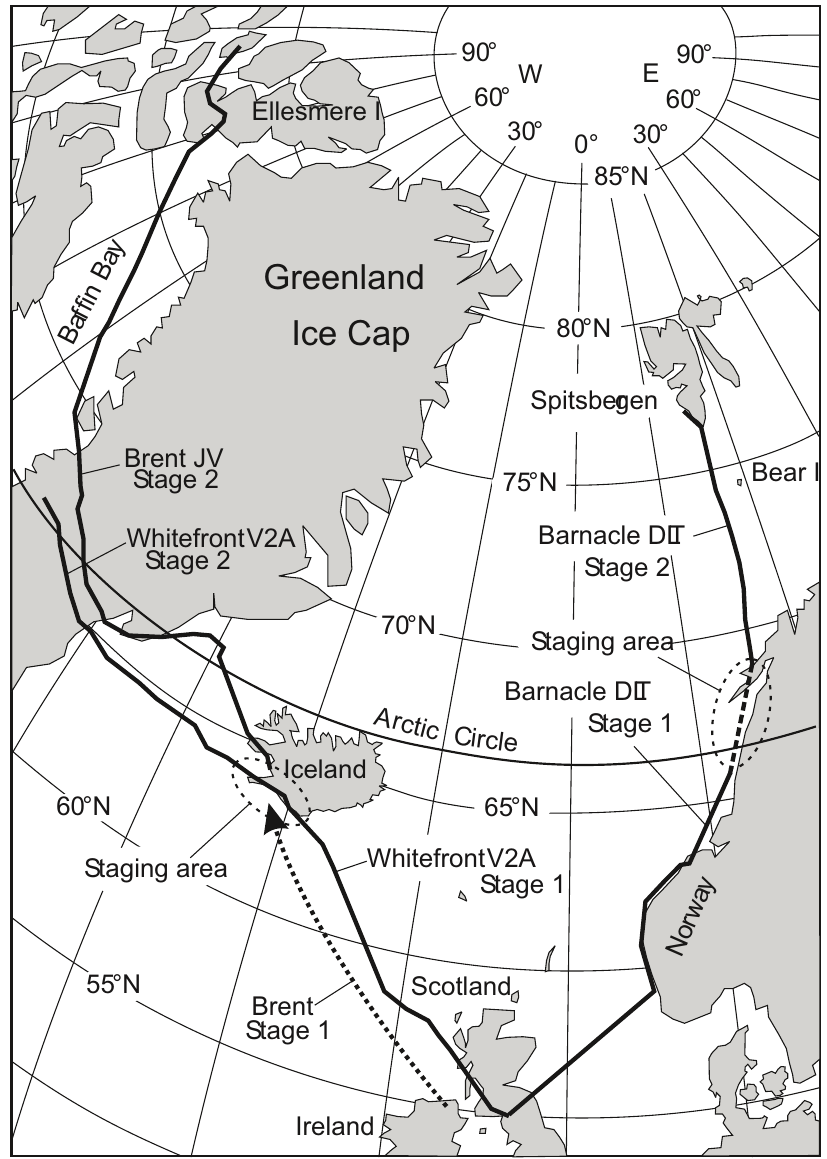
Figure 4. Migration routes of the three species of geese tracked during the spring migration of 2008. Positions were GPS recorded, usually every 2